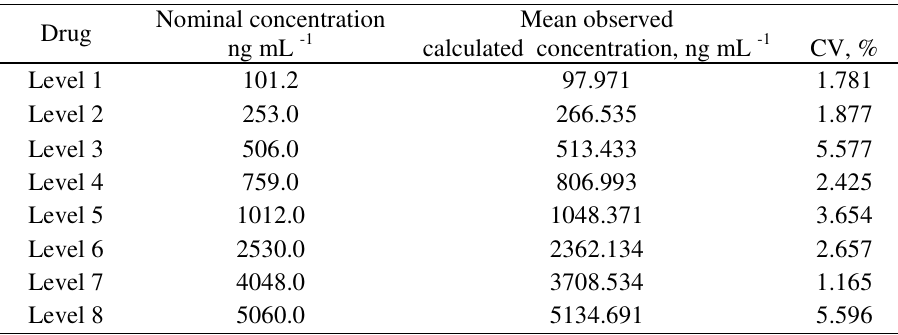
Table 2. Data of standard